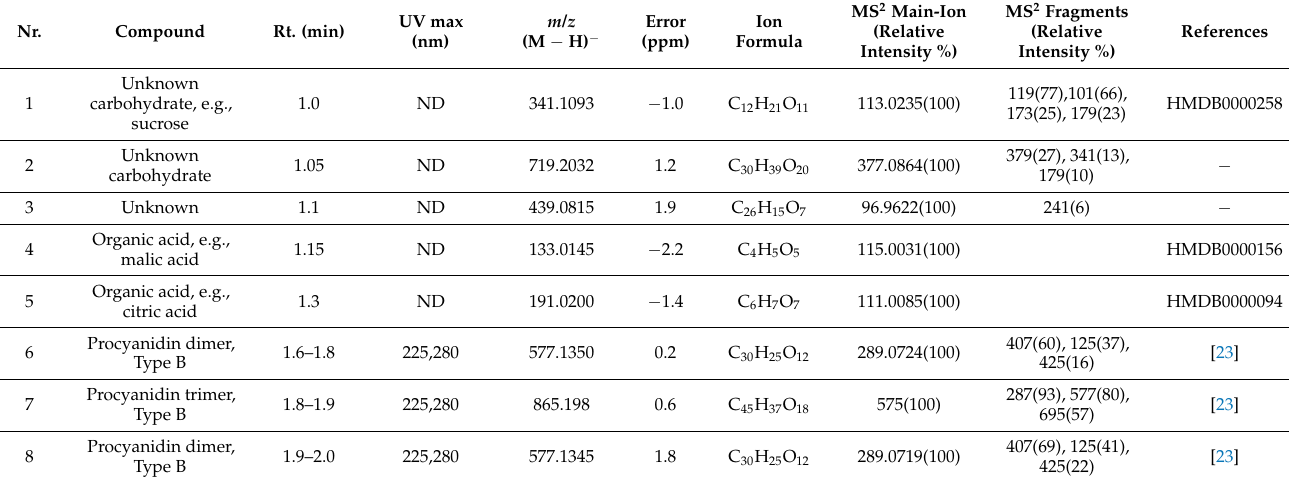
Table 3. Retention times, UV λ max, MS data, and ion formula suggestion of the constituents present in the extracts of R. japonica